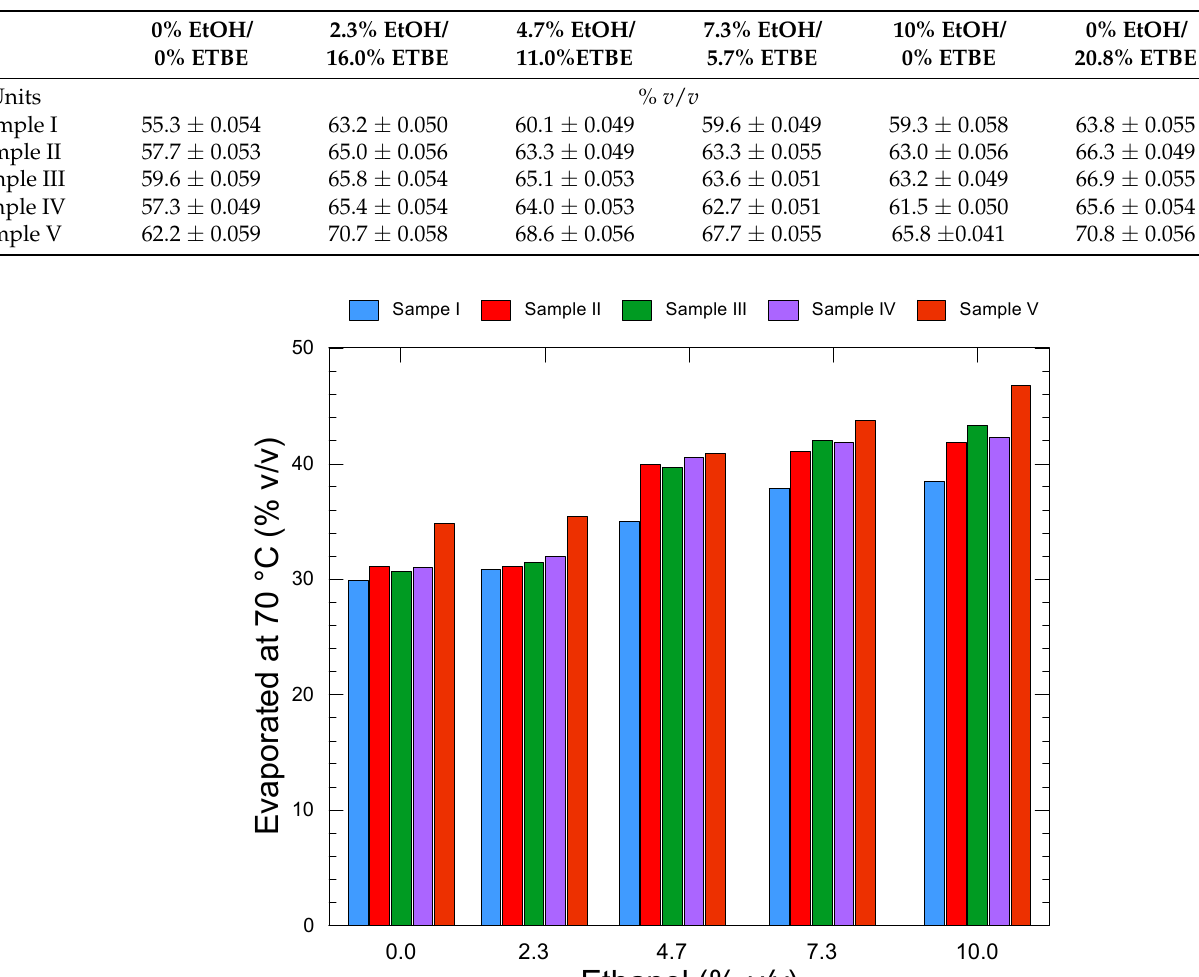
Table 9. E100 of base fuels and bio-EtOH/bio-ETBE blends.